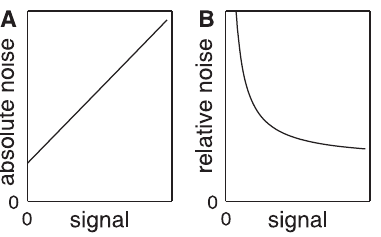
Figure 1. Neural noise. A: The absolute noise in a neural signal increases linearly with the magnitude of the signal (signal-dependent noise) in addition to a constant noise factor (signal-independent noise). B: The relative noise in a neural signal (defined as the absolute noise divided by the magnitude of the signal) decreases with the magnitude of the